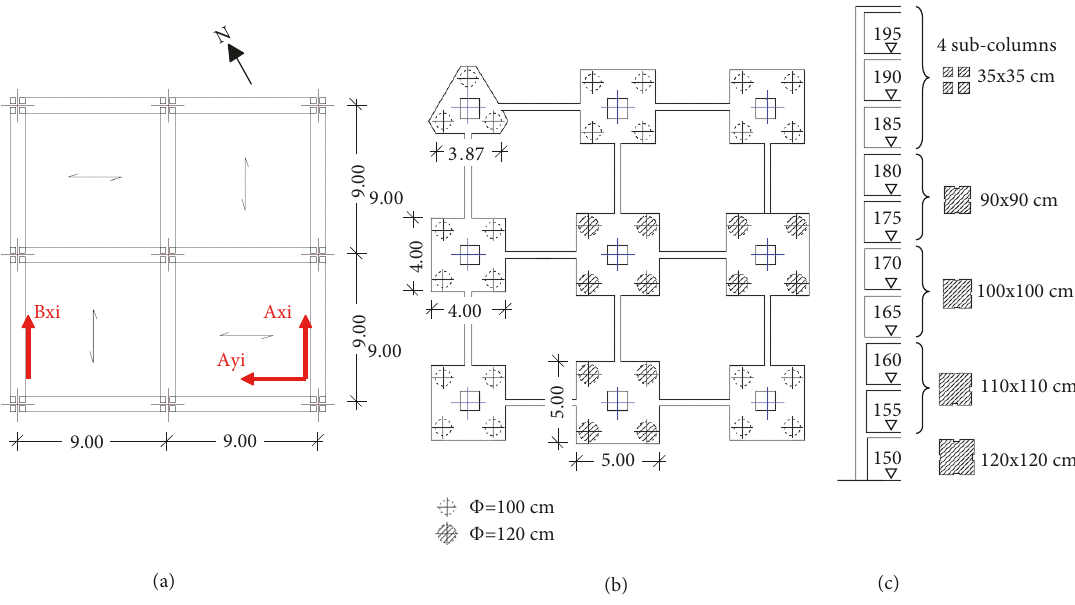
Figure 2: (a) Typical floor plan, (b) foundation layout, and (c) columns cross sections.